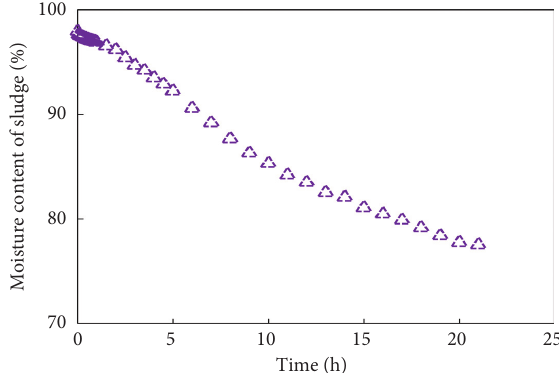
Figure 11: Sludge moisture content with rice